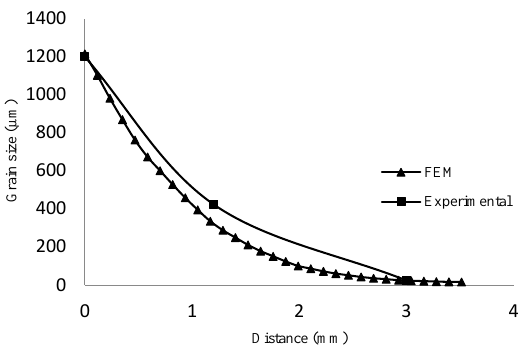
Figure 8. Average grain size taken from adjacent to fusion line through HAZ for AISI 1045 steel.